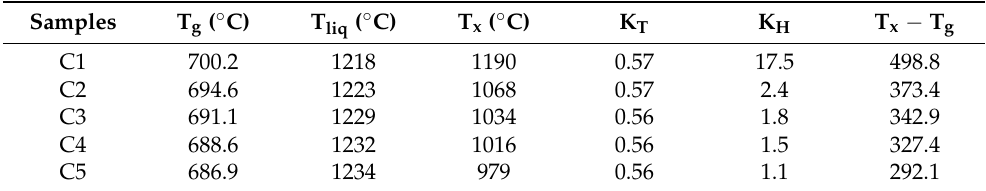
Table 4. Temperature in ◦ C of T g , T liq and T x and values of K T and K H determined by using above equations.